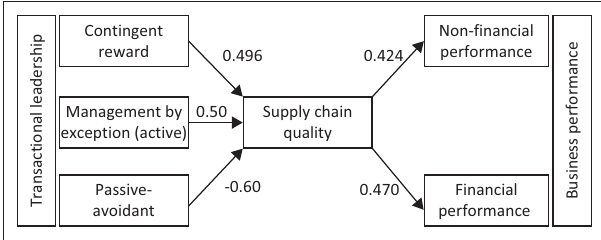
FIGURE 2: Conceptual model with final